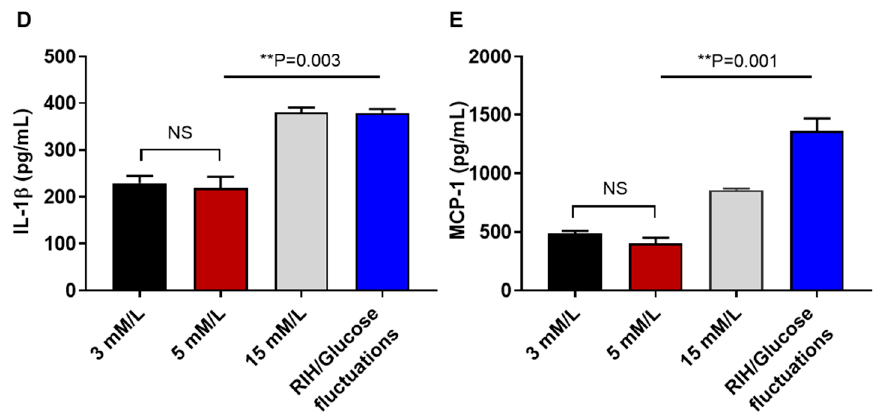
Figure 2. IRF5 upregulation is accompanied by increased M1 macrophage polarization markers and pro-inflammatory cytokines expression. THP-1 transformed macrophages were cultured for 3 days under conditions of hypoglycemia (3 mM / L), normoglycemia (5 mM / L), persistent medium hyperglycemia (15 mM / L), and RIH / glucose fluctuations (3–15 mM / L). Cells were harvested and stained with fluorescent antibodies against M1 / M2 macrophage markers and selected pro-inflammatory and anti-inflammatory cytokines as described in the Materials and Methods section. IL-1 β and monocyte chemoattractant protein (MCP)-1 levels in culture supernatants were measured by ELISA. Cells were also harvested for measuring gene expression of M1 / M2 polarization and inflammatory markers using real-time qRT-PCR. ( A ) Representative flow cytometry data from three independent determinations with similar results are presented as bar graphs of mean staining index (SI). ( B ) Representative flow cytometry data from three independent determinations with similar results are presented as histograms. ( C ) Representative qRT-PCR data from three independent determinations with similar results are presented as bar graphs showing selected gene expression as fold change over control gene expression taken as 1. ( D , E ) Representative ELISA data from three independent determinations with similar results are presented as bar graphs showing secreted protein levels of IL-1 β and MCP-1, respectively, in macrophage culture supernatants. All data are expressed as mean ± SEM values. *P ≤ 0.05, **P ≤ 0.01, ***P ≤ 0.001, ****P ≤ 0.0001, and NS: nonsignificant.